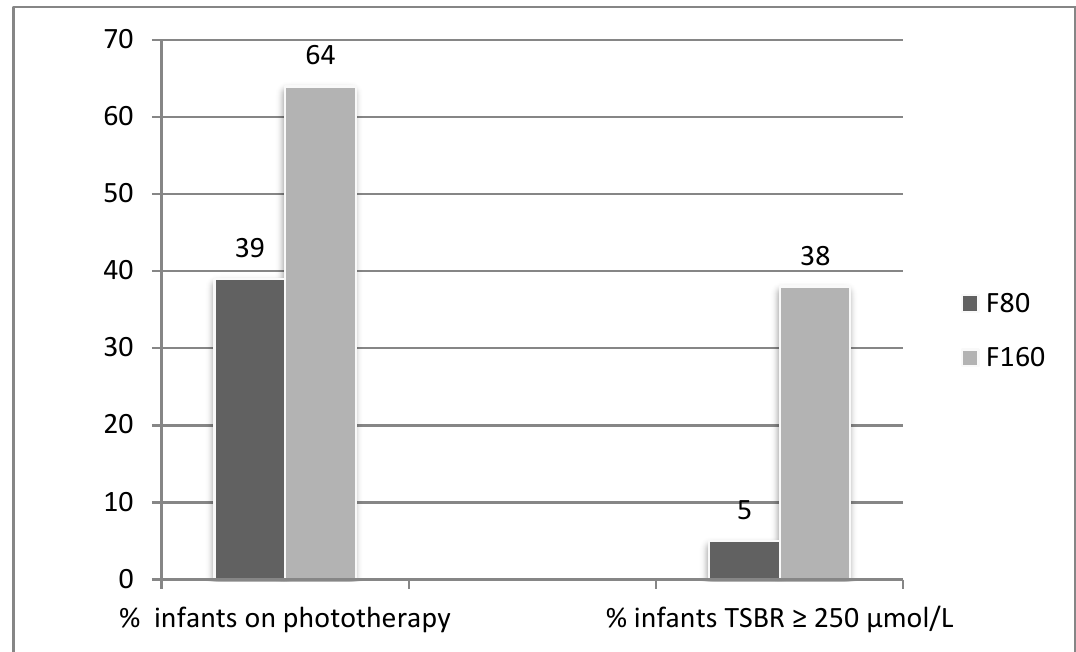
Figure 1. Proportion of infants requiring phototherapy and maximum value of TSBR (total serum bilirubin) level ≥ 250 µ mol / L. p < 0.0001 for both categories, Chi-square test for probability.